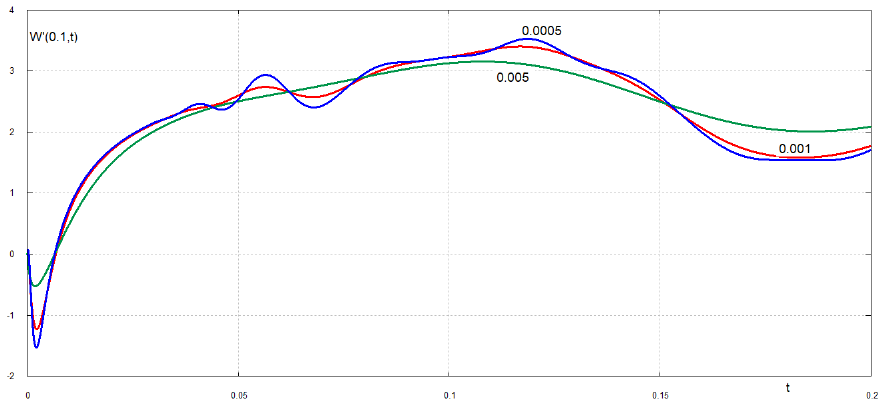
Figure 8. Dimensionless velocity of the plate near the free-free edge, x = 0.1, shortly after the plate breaking t > 0 for very small values of the dimensionless retardation time ˜ τ = 0.001,0.005,0.0005. The strain (cid:101) ( x , t ) in the plate after its breaking is given in the dimensionless variables by the formula